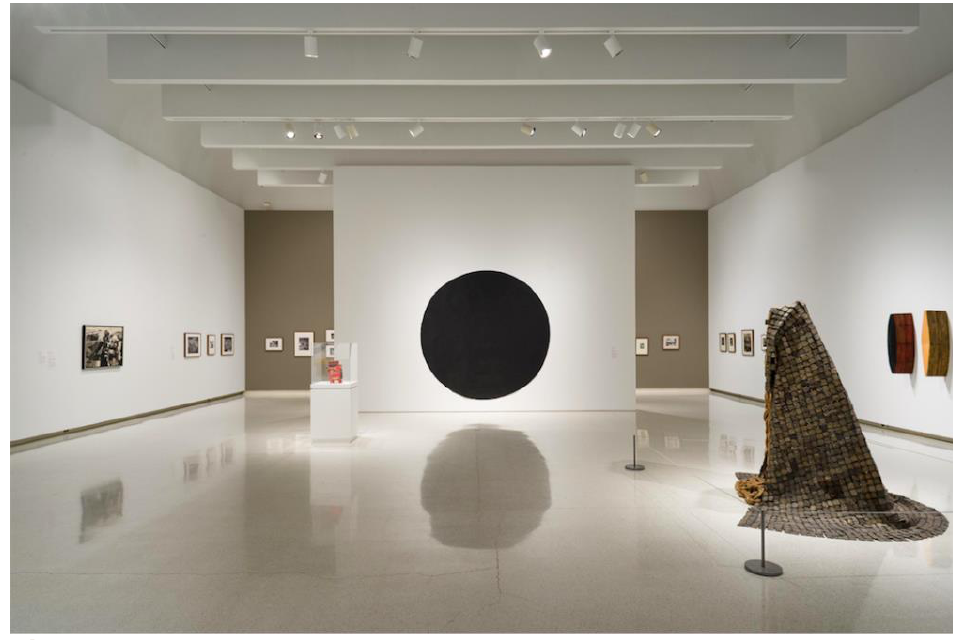
"Installation view of 20/20: The Studio Museum in Harlem and Carnegie Museum of Art. Photo: Bryan Conley." Featuring Quentin Morris, Untitled [January – February 1994] (1994).